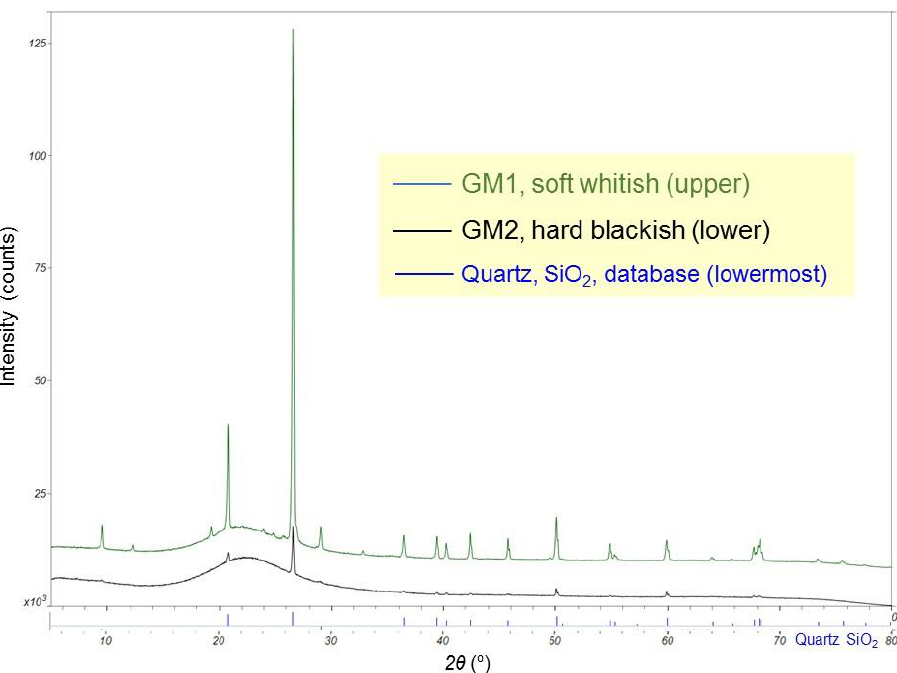
Figure 4. PXRD patterns of two speleothem types, GM1 (upper) and GM2 (lower), with the database pattern of quartz, SiO 2 (lowermost).